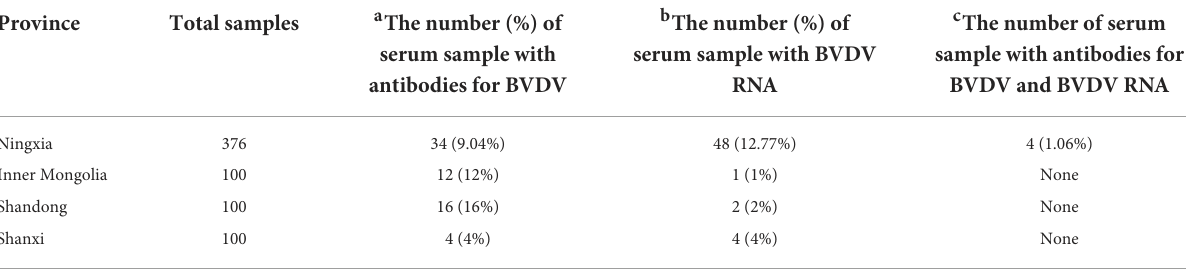
TABLE 1 The information about the target serum sample which contain BVDV genome and antibodies for BVDV. Province Total samples a The number (%) of Ningxia 376 34 (9.04%) 48 (12.77%) 4 (1.06%)